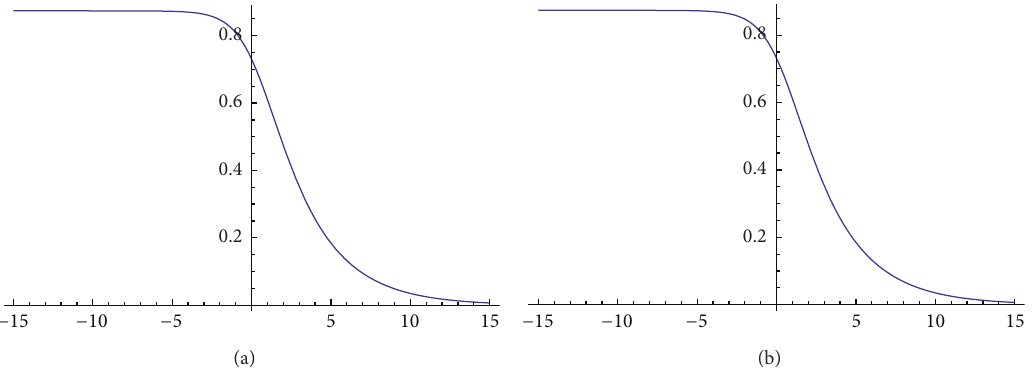
Figure 8: Two dimensional graph of the solution (33) corresponding to the values 𝛼 = 0.05 , 𝛼 = 0.85 , respectively, when 𝑘 = 1 , 𝑝 = 3 , 𝛽 = −2 , 𝑡 = 1 , and −15 < 𝑥 < 15